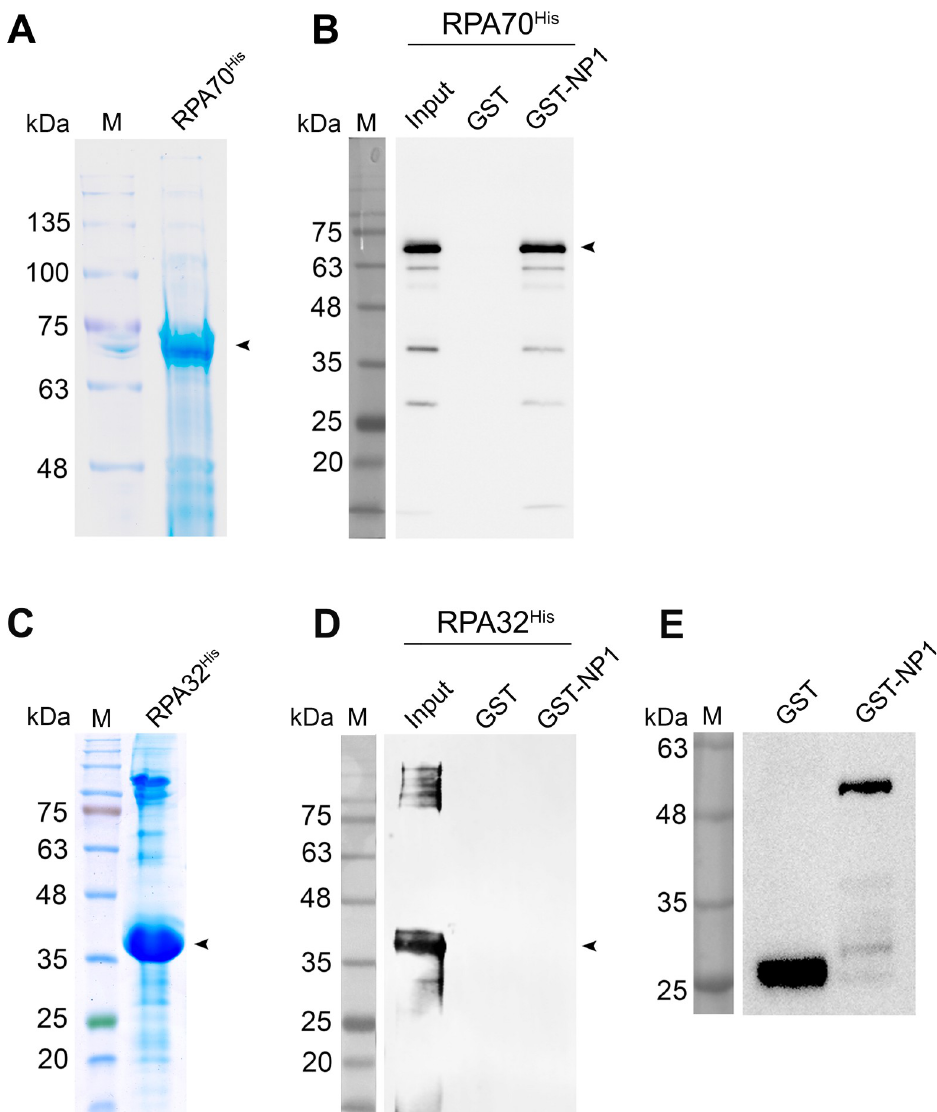
Fig 6. NP1 directly interacts with RPA70 of RPA heterotrimer. (A&C) Purification of RPA70 His and RPA32 His proteins. RPA70 His (A) and RPA32 His (C) were purified and separated on an SDS-PAGE gel followed by Coomassie brilliant blue staining. (B&D) In vitro pull-down assay of RPA70 His and RPA32 His . 4 μ g of purified GST-NP1 were used as bait to pull down 4 μ g of prey proteins, purified RPA70 His (B) and RPA32 His (D), respectively, using Glutathione agarose. Pulldown proteins were analyzed by Western blotting with an anti-His antibody (B&D) or with anti-GST as a control (E). 4 μ g GST of prey protein served as a negative control. Purified proteins and detected protein are denoted with